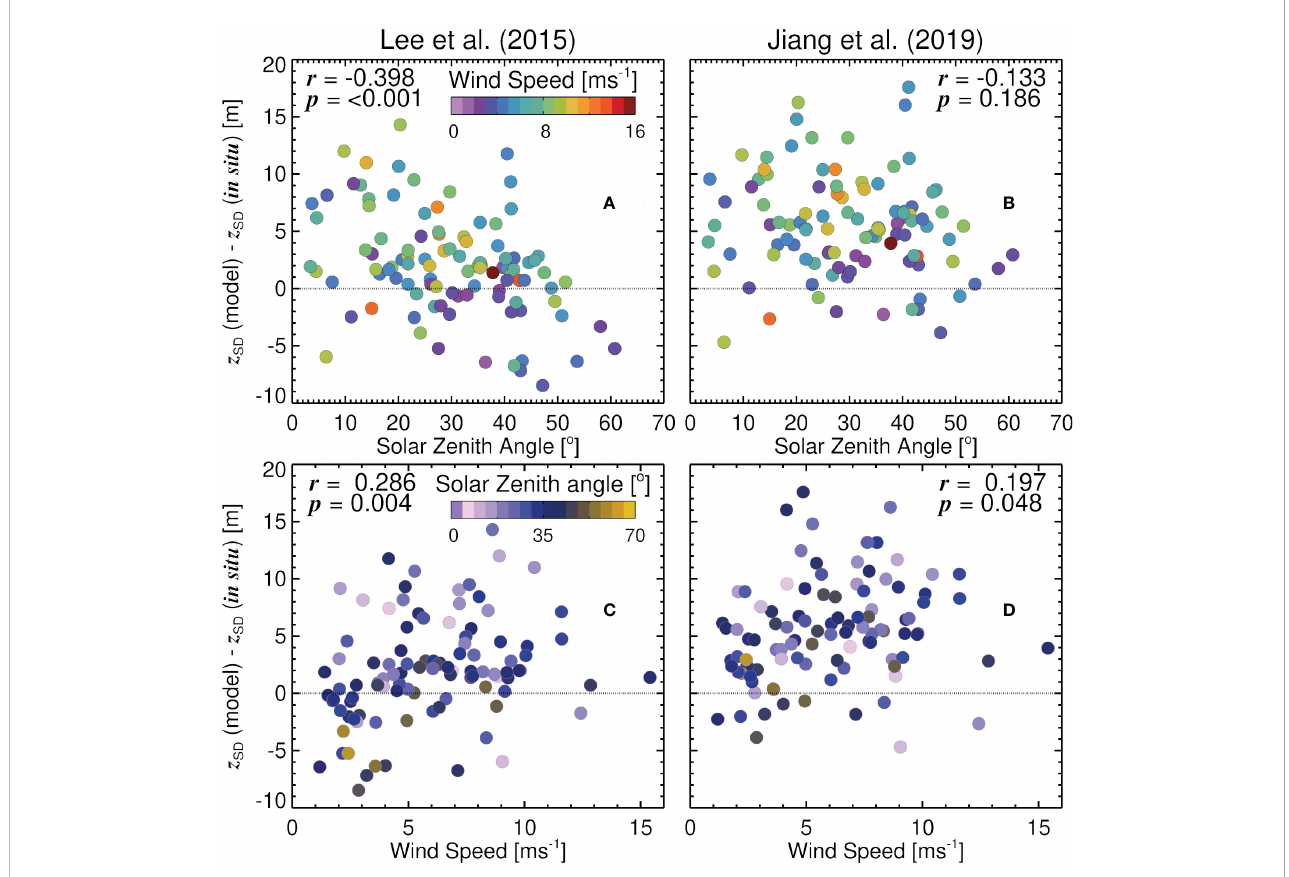
FIGURE 8 Differences (residuals) between R rs -derived Secchi depth (z SD ) and in-situ z SD , using the algorithms of Lee et al. (2015) (A, C) and Jiang et al. (2019) (B , D) , plotted as a function of solar zenith angle ( q ) (A, B) and wind speed ( w s ) (C, D) . Dotted line represents residuals of